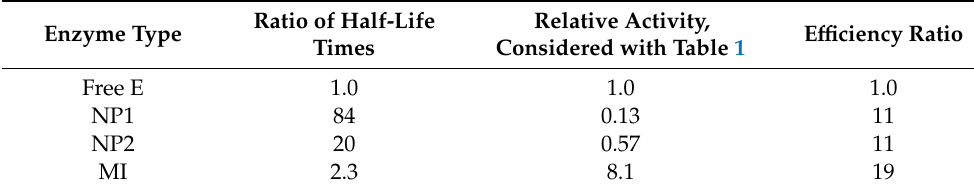
Table 3. Comparison of e ffi ciency of 1 mg α -chymotrypsin enzyme pretreated by di ff erent methods, calculated as product of half-life times and initial activities. Free E: not immobilized α -chymotrypsin enzyme; NP1 (three-step synthesis method) enzyme nanoparticles with trimethoxysilyl polymers; NP2 (two-step synthesis method) enzyme nanoparticles with acrylamide-bisacrylamide layer. MI: